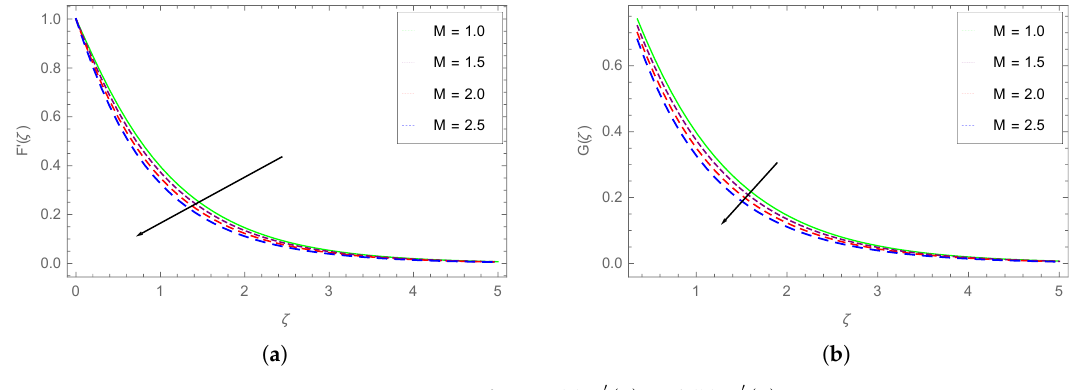
Figure 2. Impact of M on ( a ) F (cid:48) ( ζ ) and ( b ) G (cid:48) ( ζ )